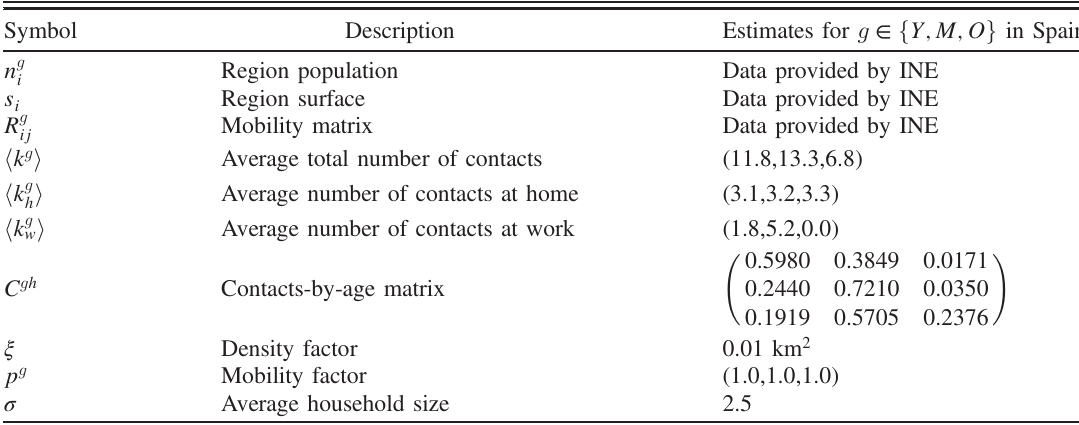
TABLE I. Parameters of the model related to geographic and population data, including mobility, and their values for Spain. See Appendix A for a detailed explanation.